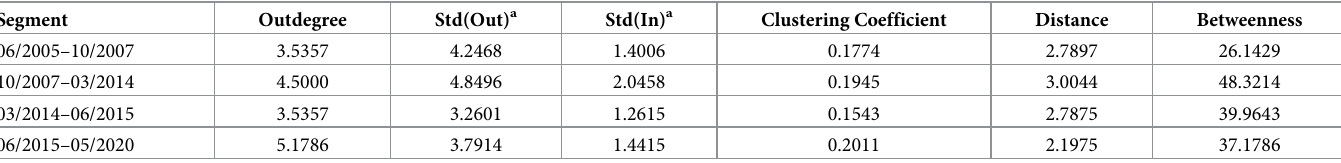
Table 2. Results of industry index over four